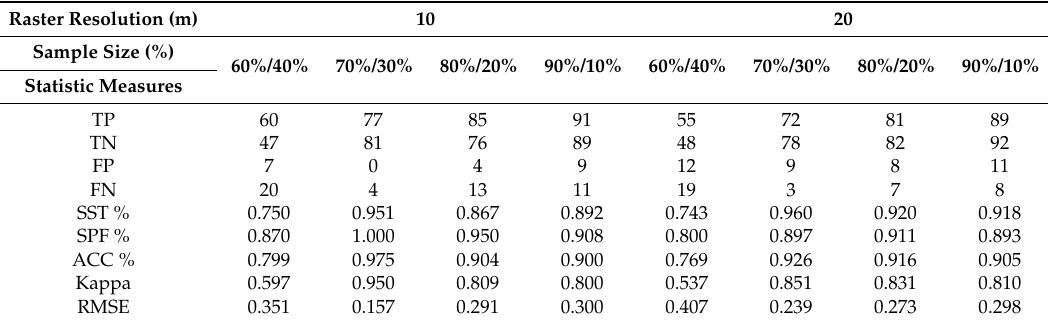
Table 3. Model performance using training dataset and ADTree